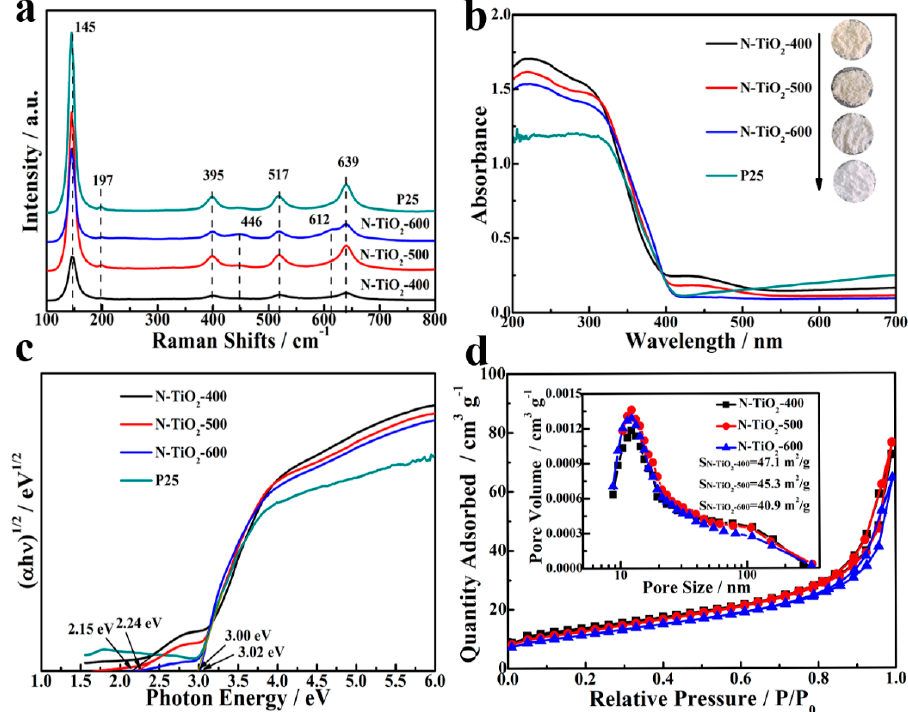
Figure 4. Raman spectra ( a ); UV-DRS spectra and color photograph (inset) ( b ); band gap energies curves ( c ); nitrogen adsorption–desorption isotherms and corresponding pore size distribution curves ( d ) of different samples.